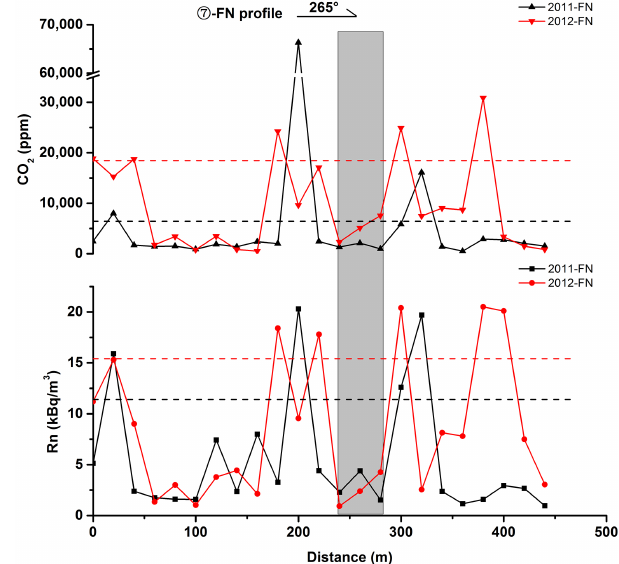
Figure 9. Rn and CO 2 concentrations along the GY profile across the Tangshan Fault. The shaded bar represents the location of the fault. The black and red dotted lines represent the anomaly threshold of soil gas in 2011 and 2012, respectively. The arrow at the top (with number above) represents the direction of the profile.